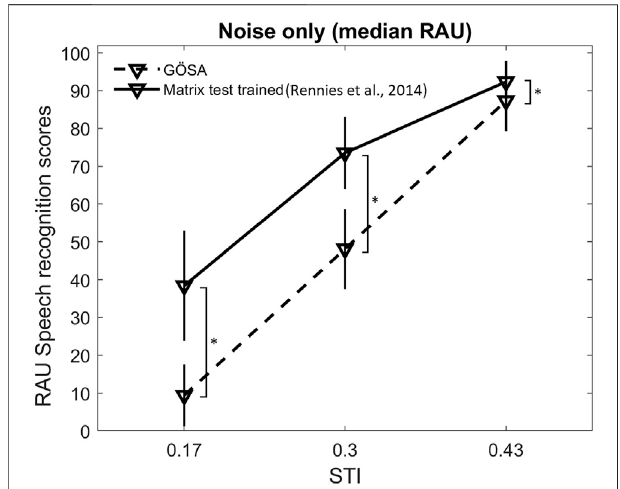
FIGURE 3 | Median RAU recognition scores and corresponding interquartile ranges for everyday sentence test (GÖSA) and trained German matrix test (data from Rennies et al., 2014) measured in stationary noise at different signal-to-noise ratios. Stars indicate statistically signi fi cant differences across measurements